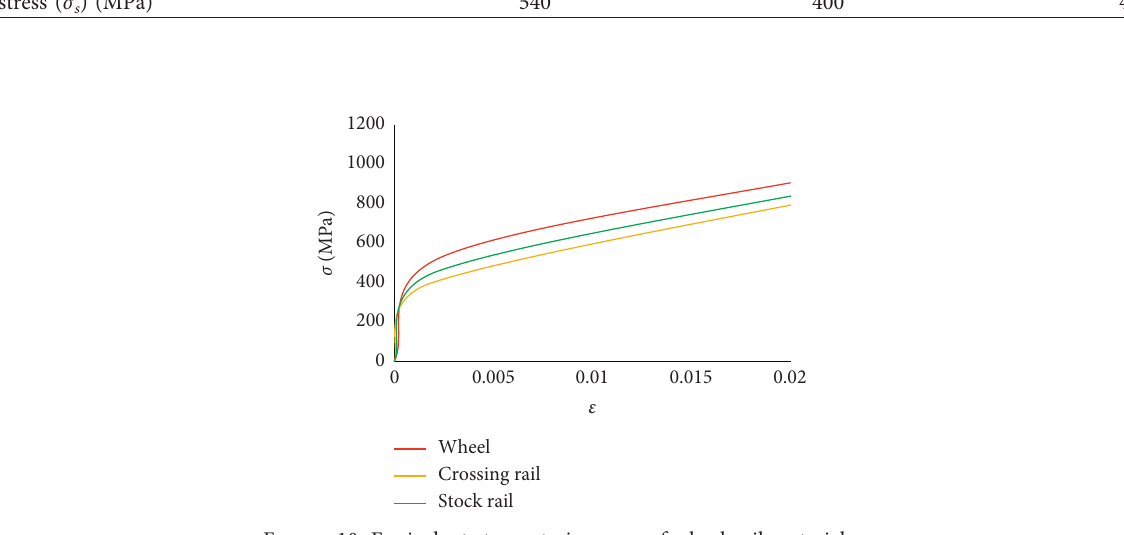
Figure 10: Equivalent stress-strain curve of wheel-rail materials.